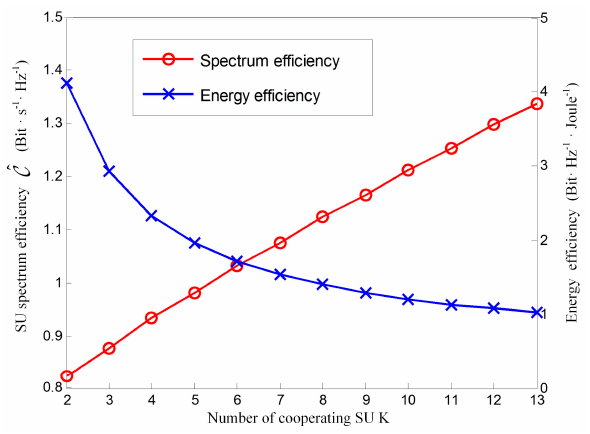
Figure 12. SU spectral efficiency and energy efficiency versus the number of cooperating SU for the novel ST-CSS